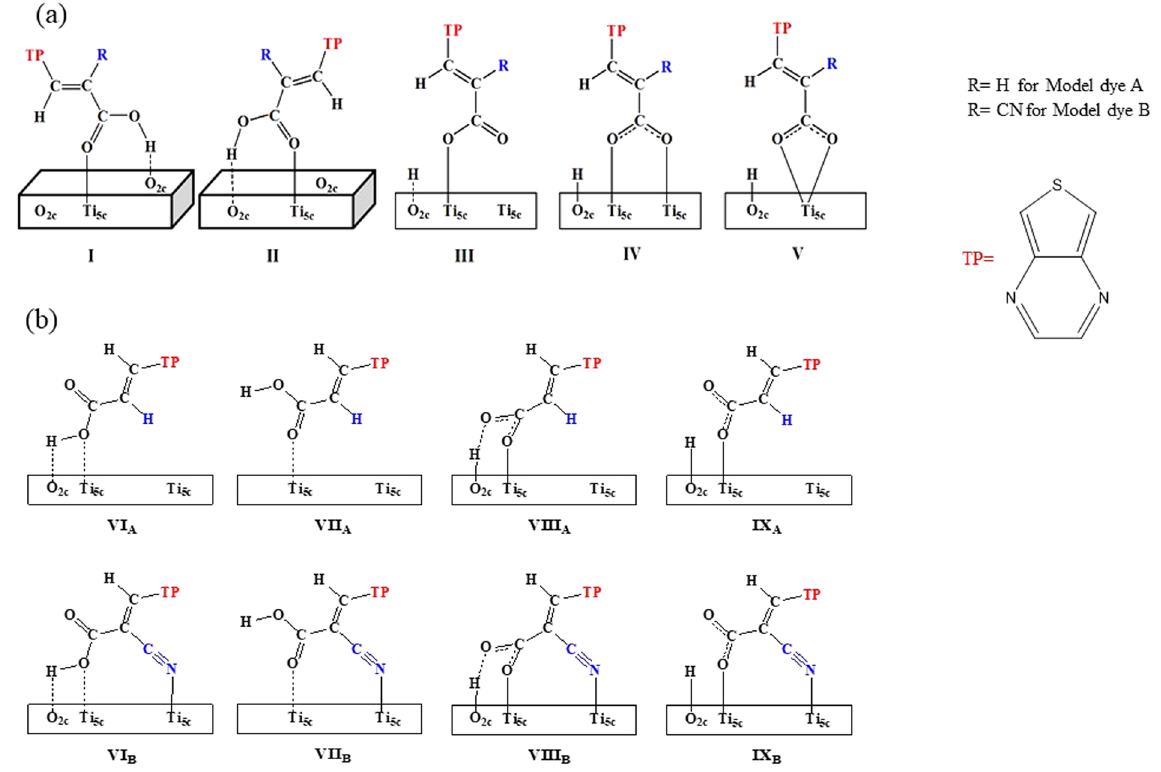
Figure 1. The schematic representation of considered adsorption configurations for model dyes A: TP-COOH and B: TP- CN COOH. (( a ) configurations I-V for both dyes A and B adsorbed on surface via O-Ti bond and ( b ) configurations VI-IX for dye A adsorbed via O-Ti bond, and for dye B adsorbed via both O-Ti and N-Ti on TiO 2